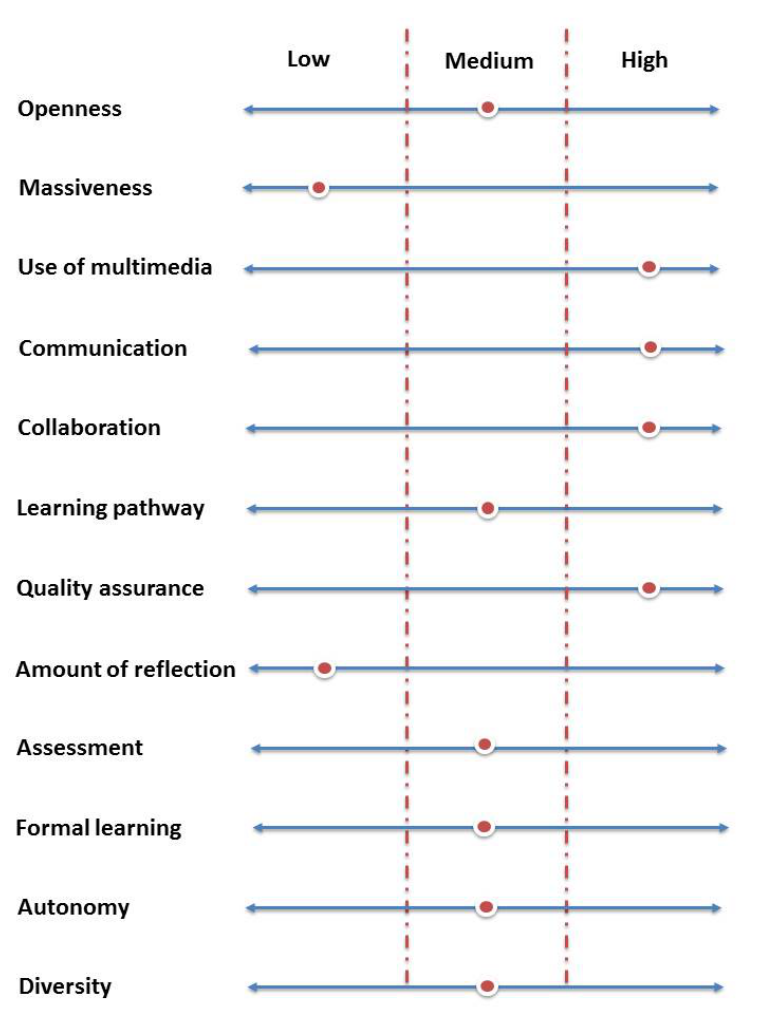
Figure 4 . Evaluation of the bMOOC based on Conole’s 12 Dimensions